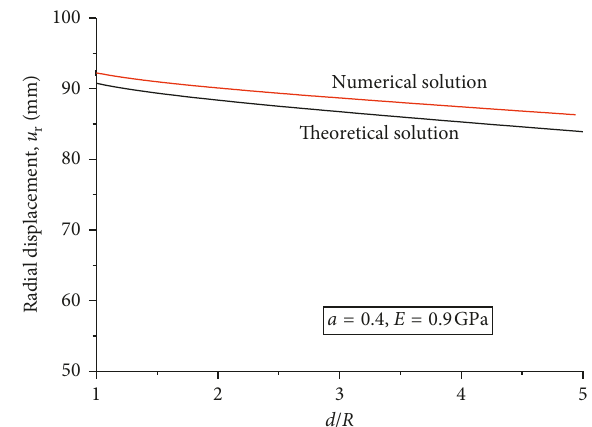
Figure 13: Radial displacement of surrounding rock when α